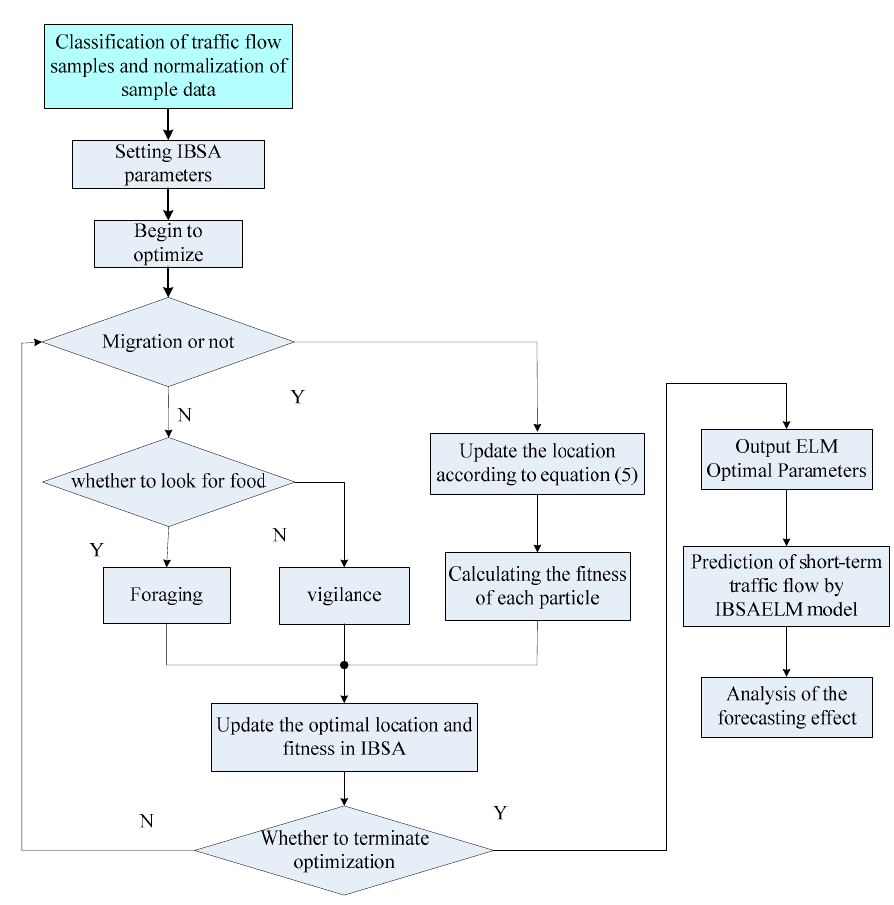
Figure 2. Short-term traffic flow prediction.